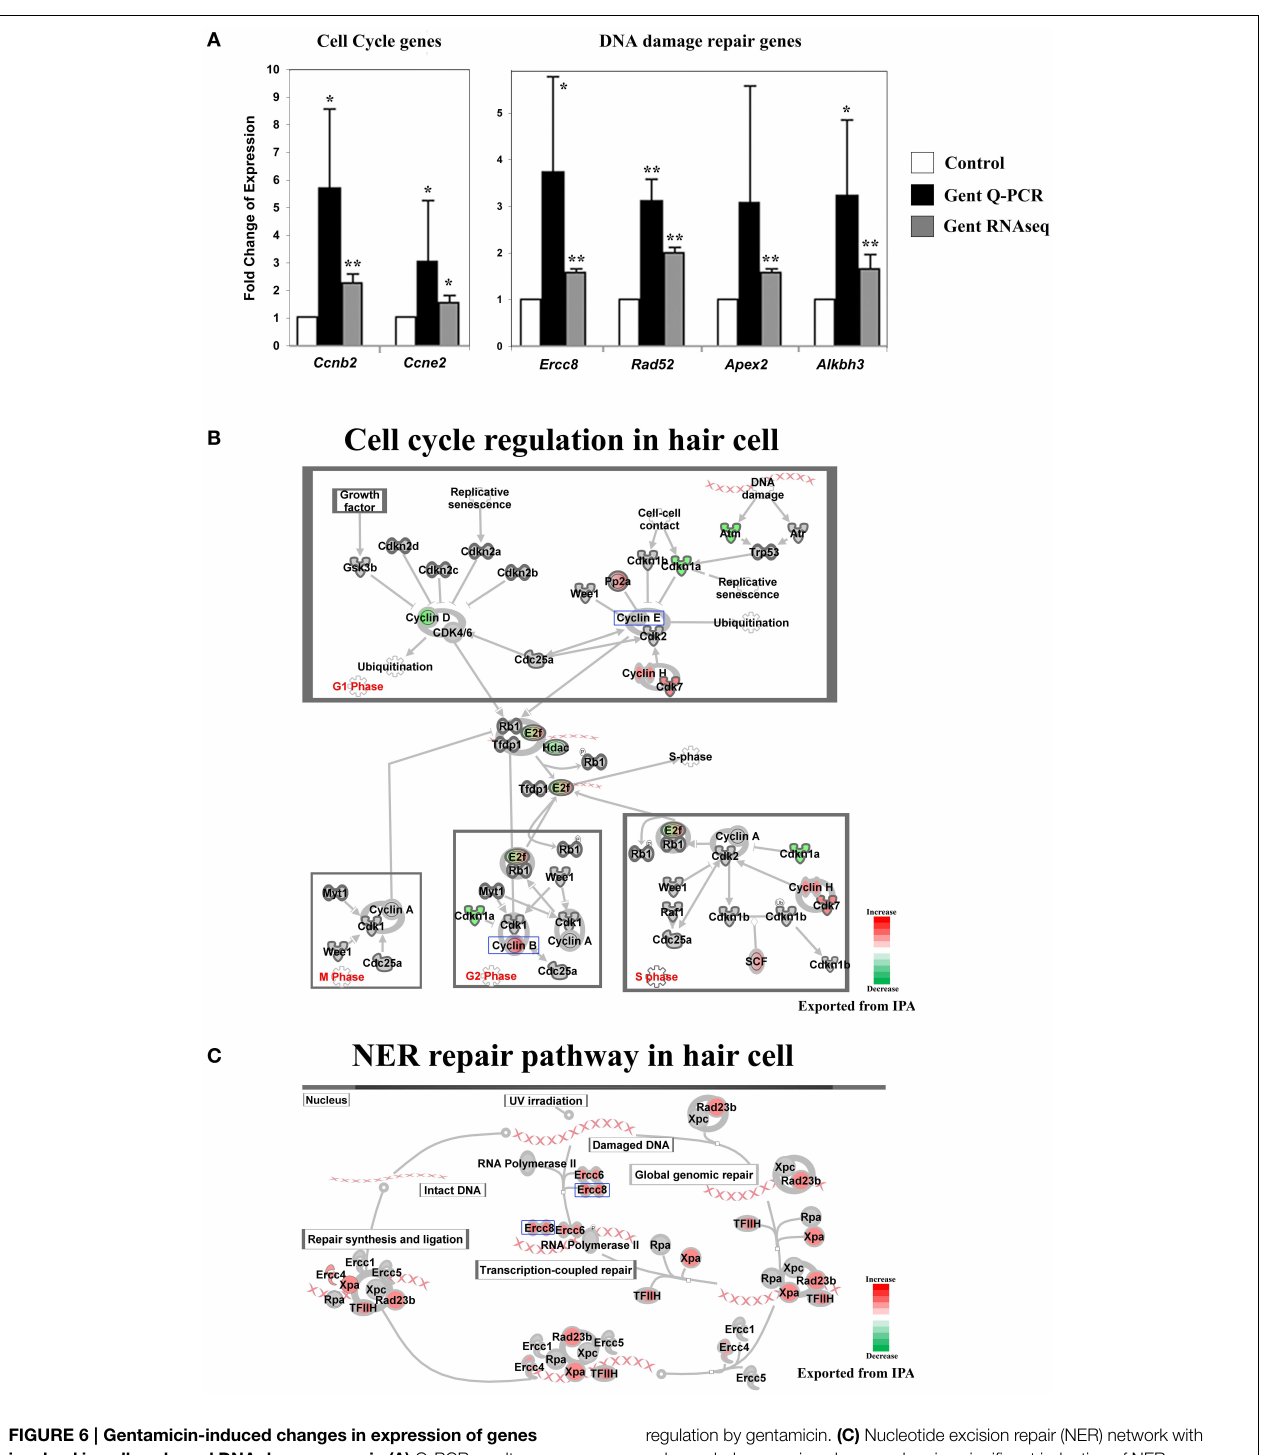
regulation by gentamicin. (C) Nucleotide excision repair (NER) network with color-coded expression changes showing significant induction of NER genes. Only genes with significant expression changes are colored. Red, increased expression; green, decreased expression relative to control; half red-half green, indicates nodes with multiple genes with some genes upregulated and some genes downregulated. Genes validated and discussed in the text are boxed in the corresponding protein pathway